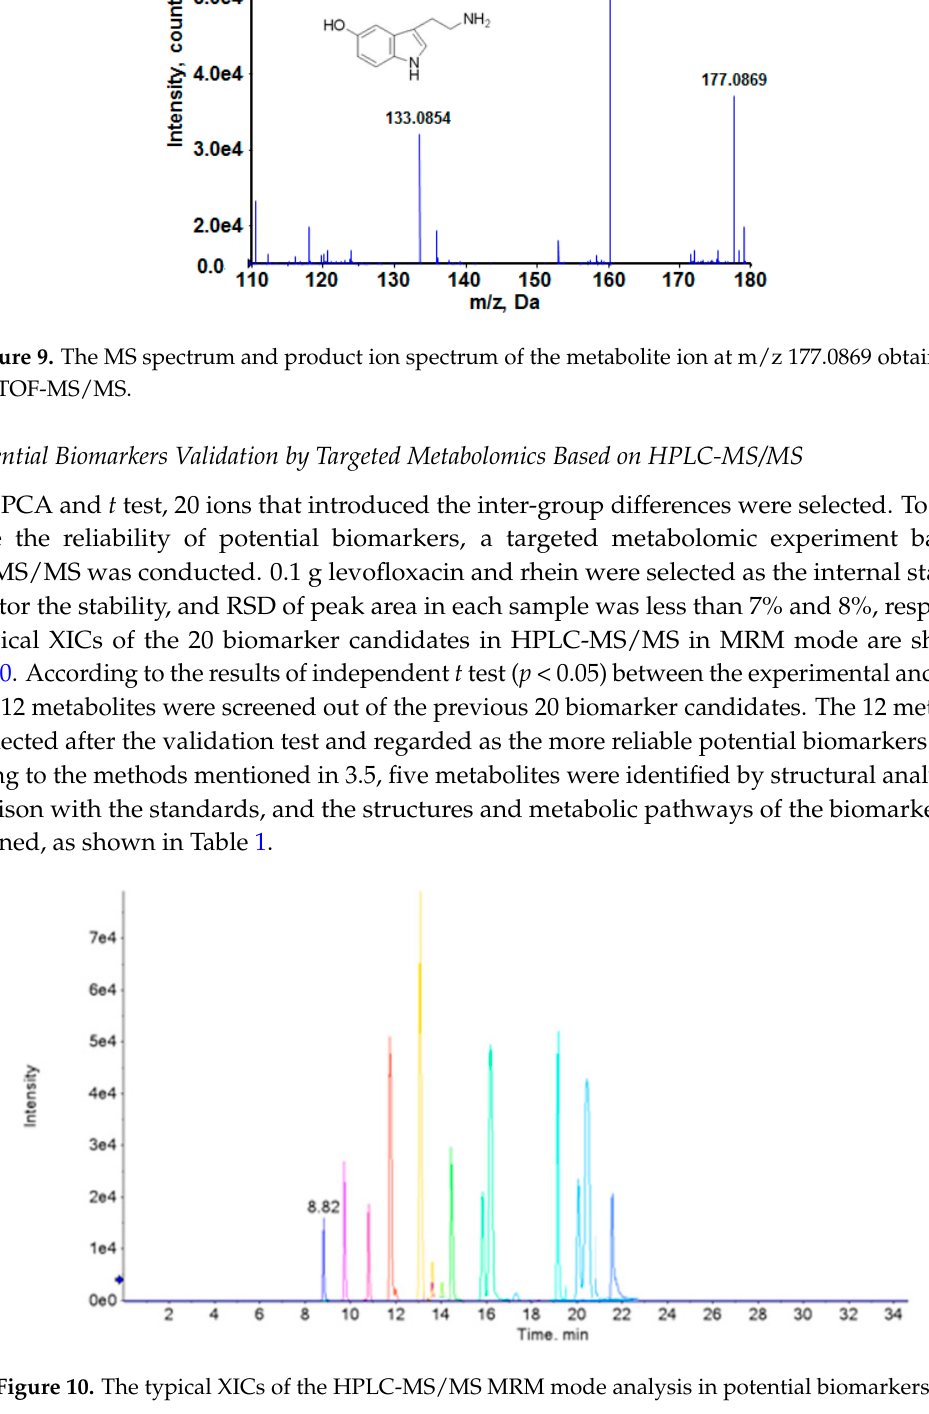
Figure 9. The MS spectrum and product ion spectrum of the metabolite ion at m/z 177.0869 obtained by TOF-MS/MS.